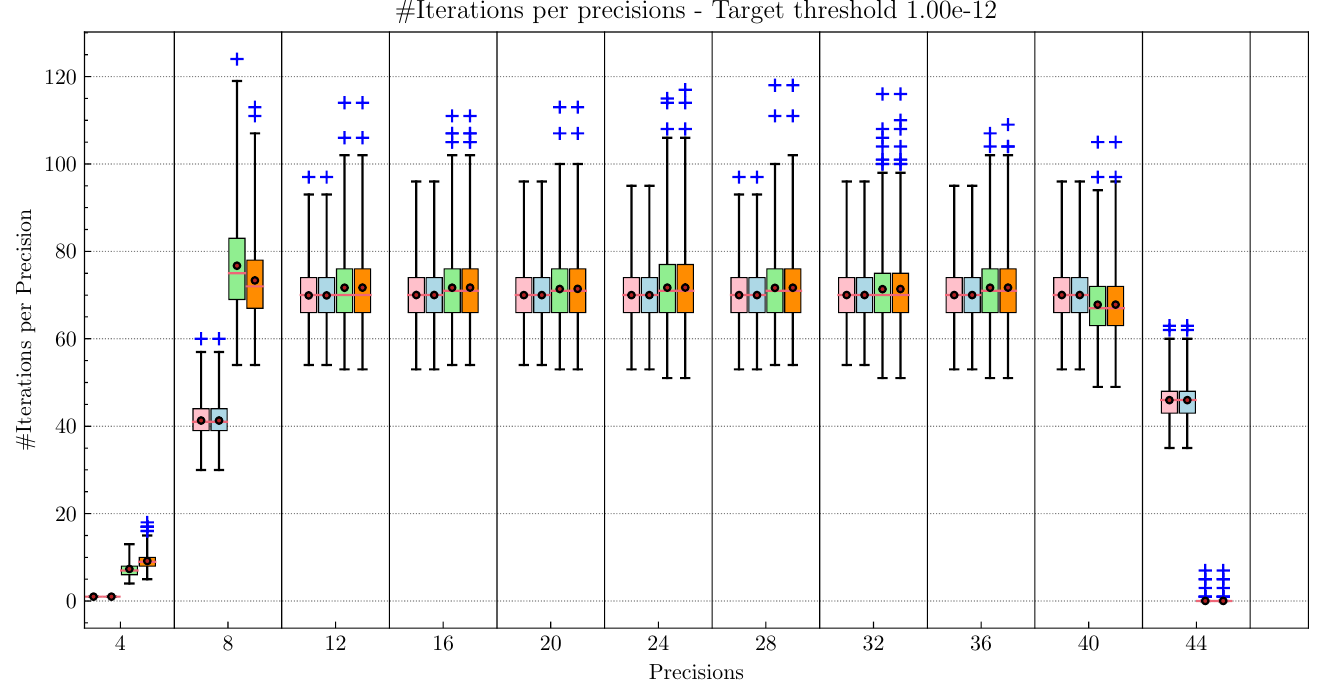
Figure 16. Iterations’ distribution per precision for TOL = 10 − 12